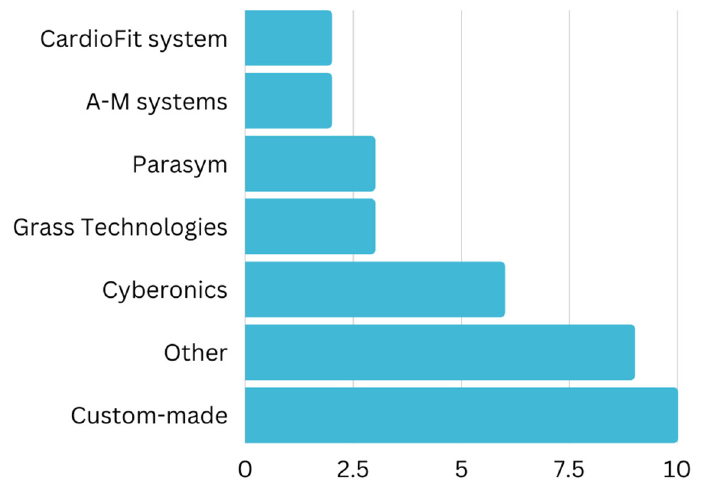
Figure 4. This bar chart represents the frequency of various VNS devices used among the studies (n = 35).